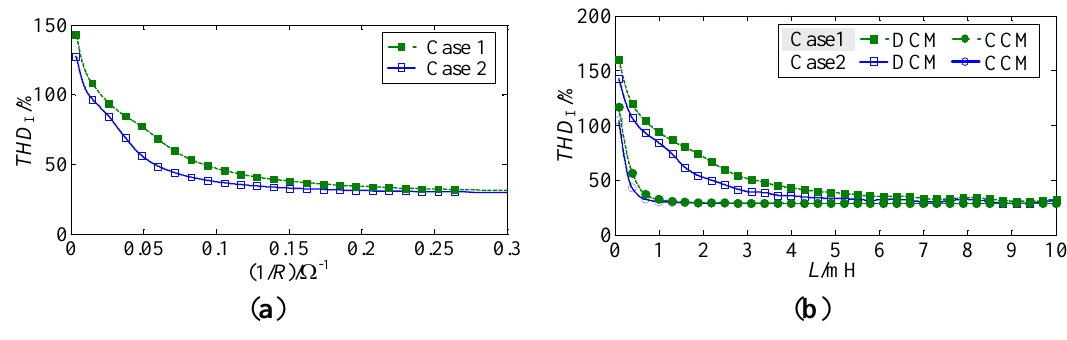
Figure 6. Sensitivity analysis of the circuit parameters of the charger: ( a ) load resistance; ( b ) filter inductance and ( c ) filter